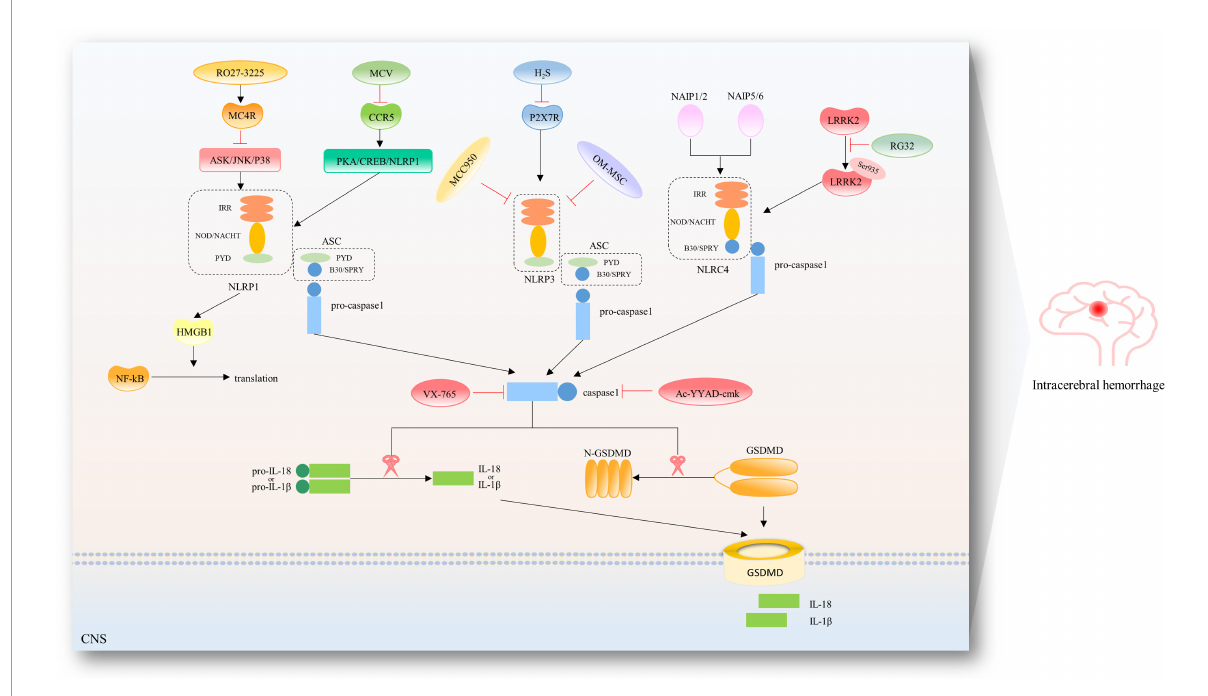
FIGURE3 Therapeutic targets in the pyroptotic pathways after ICH. To date, several inhibitors have been described for the NLRP1/NLRP3/NLRC4 inflammasome and caspase-1 after ICH. RO27-3225 suppressed NLRP1-dependent pyroptosis via inhibiting MC4R-mediated ASK/JNK/P38 MAPK signaling pathway. Maraviroc (MVC) suppressed PKA/CREB/NLRP1 signaling pathway via inhibiting CCR5. Hydrogen sulfide (H 2 S) attenuated NLRP3 inflammasome by inhibiting P2 × 7 receptor. Hypoxia-pretreated olfactory mucosal mesenchymal stem cells (OM-MSCs) are known to decrease the expression of NLRP3 inflammasome. Additionally, specific inhibition of NLRP3 has been reported by studies using its derivative MCC950. RGS2 suppressed the interaction of LRRK2 and NLRC4 and NLRC4 inflammasome activation by regulating pLRRK2. Belnacasan (VX-765) and Ac-YYAD-cmk are bioavailable prodrugs of a potent inhibitor for